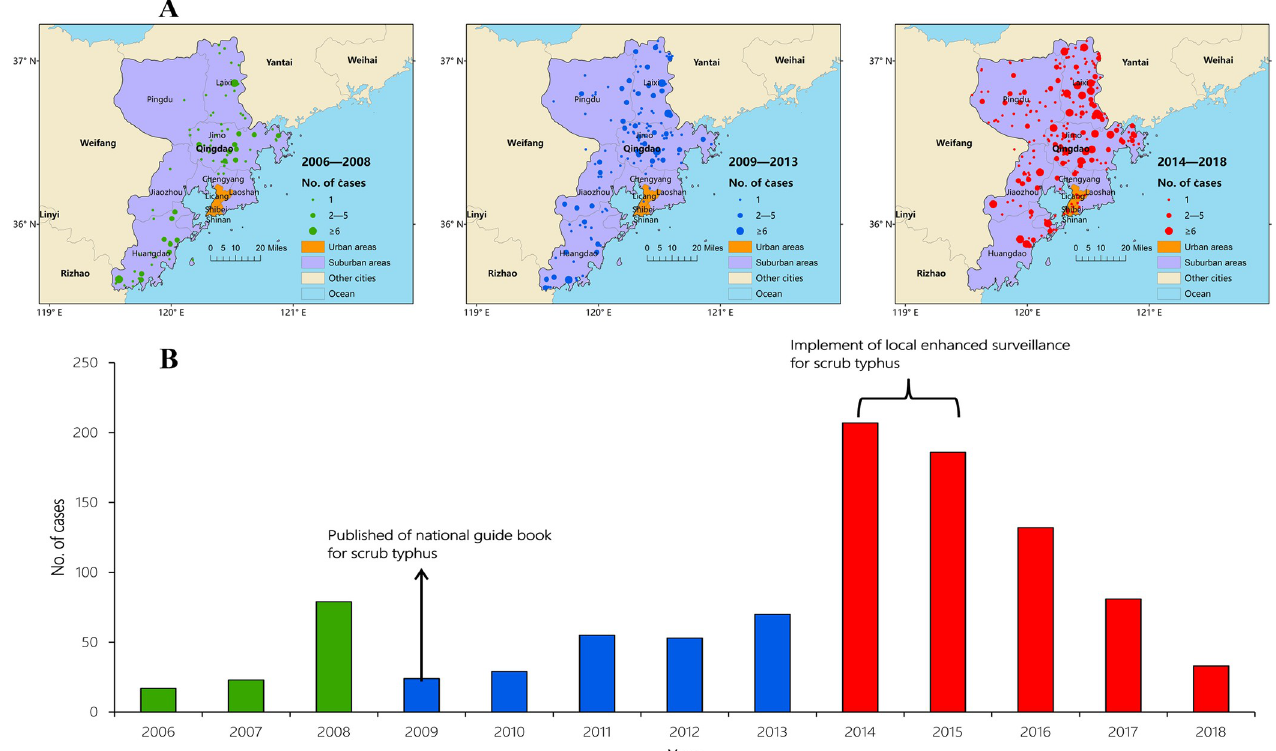
Fig 2. A) Map showing the distribution of the 379 spatial coordinates of scrub typhus records in Qingdao city. The locations are classified by year of occurrence to show those that occurred (i) between 2006–2008, before the publication of the national guide book for scrub typhus; (ii) between 2009–2013, after the publication of the national guide book for scrub typhus; and (iii) between 2014–2018, after the implementation of enhanced surveillance for scrub typhus in Qingdao city. B) The number of scrub typhus cases reported in Qingdao city over time